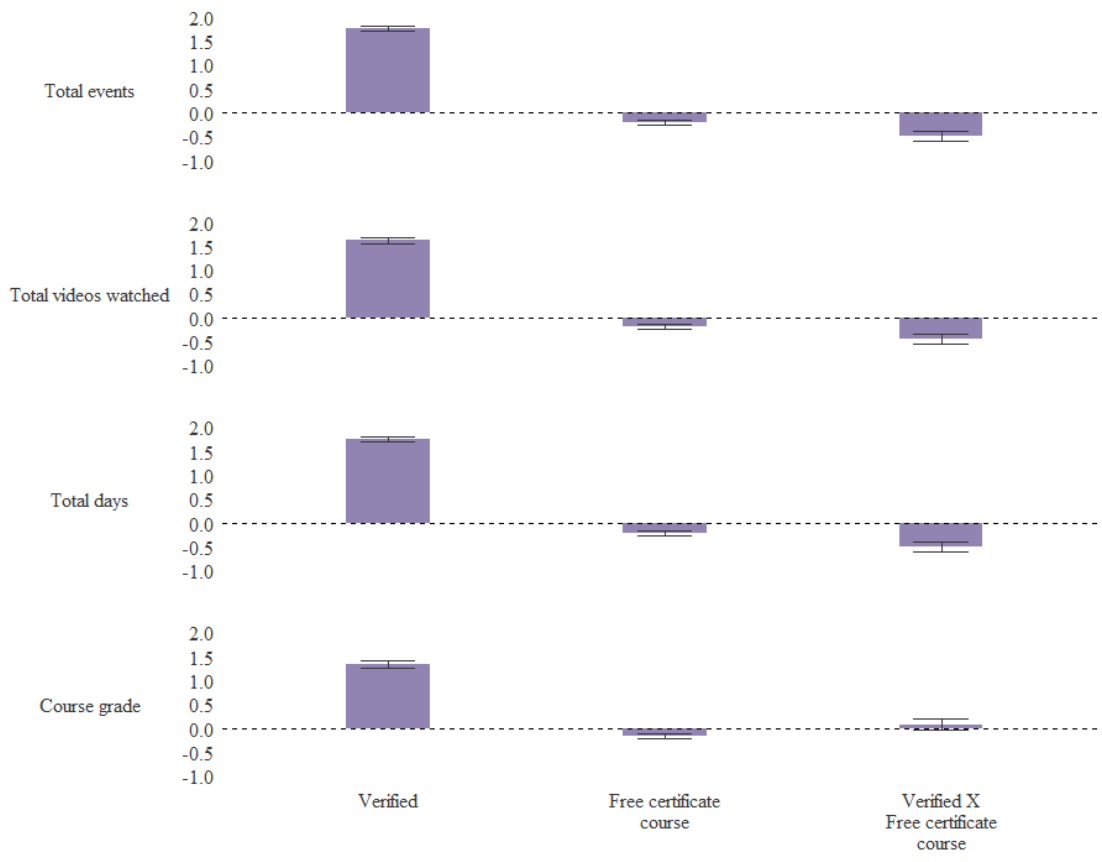
Figure 2 . Case study 1: Regression